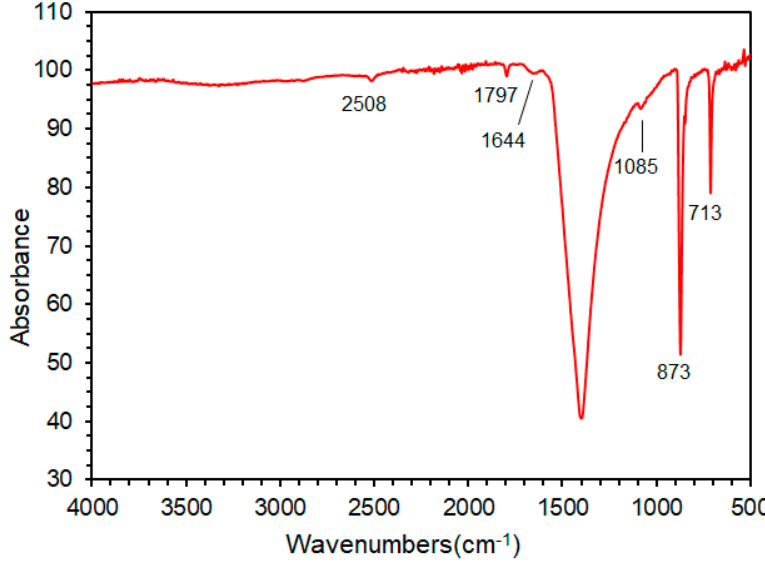
Figure 7. FTIR spectroscopy analysis of EP.